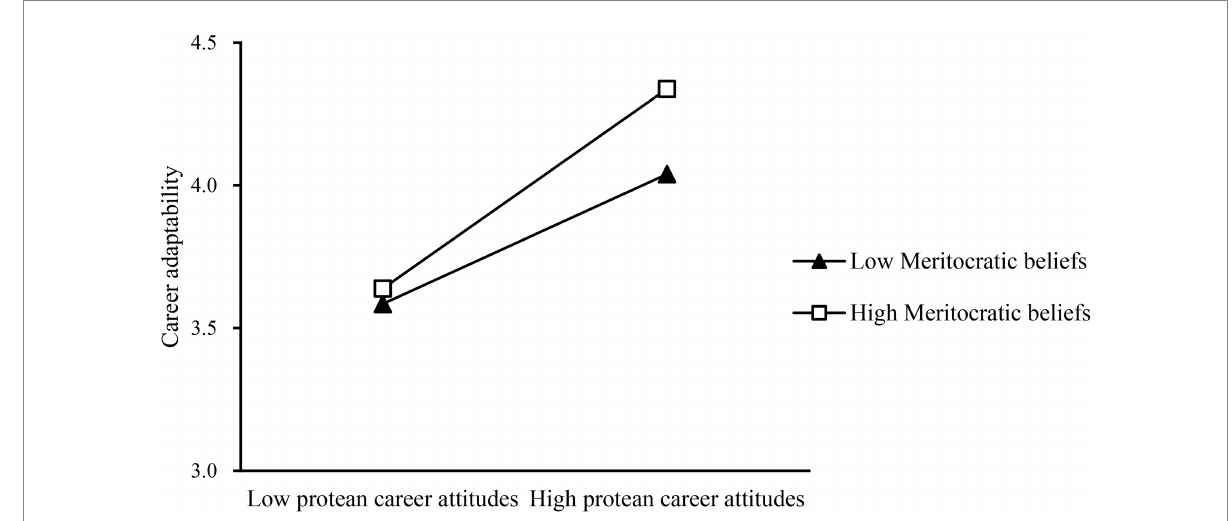
FIGURE 3 Interactive effect of protean career attitudes and meritocratic beliefs on career adaptability.